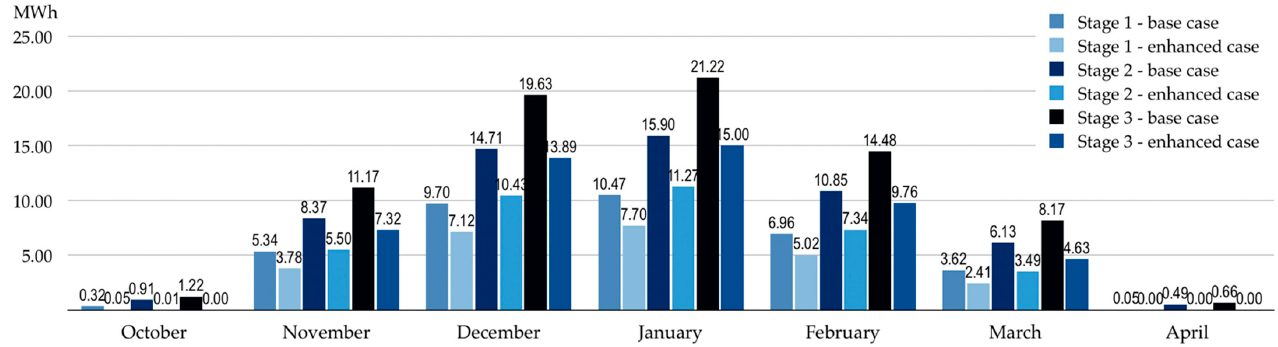
Figure 13. Energy needed for